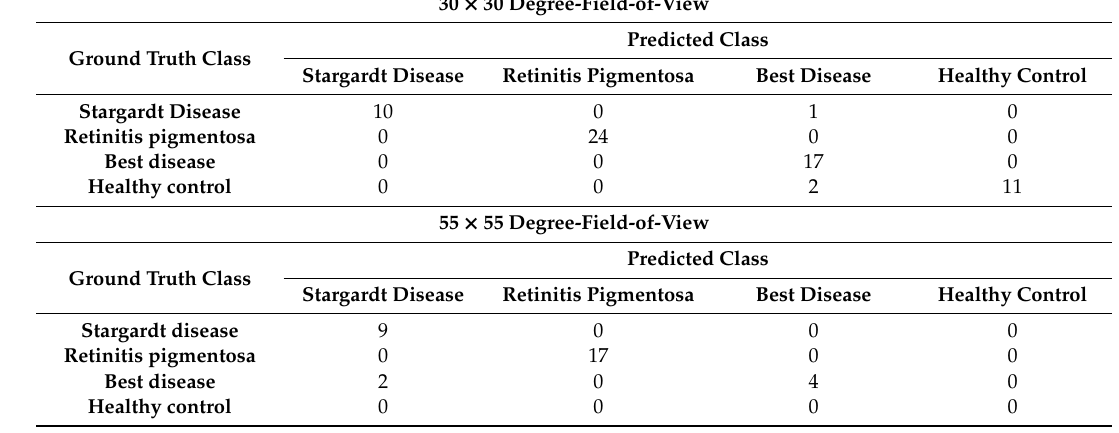
Table 3. Confusion matrix of the deep learning classifier test dataset for 30 × 30 degree-field-of-view (test dataset = 66 images) and 55 × 55 degree-field-of-view (test dataset = 32 images) fundus autofluorescence (FAF)